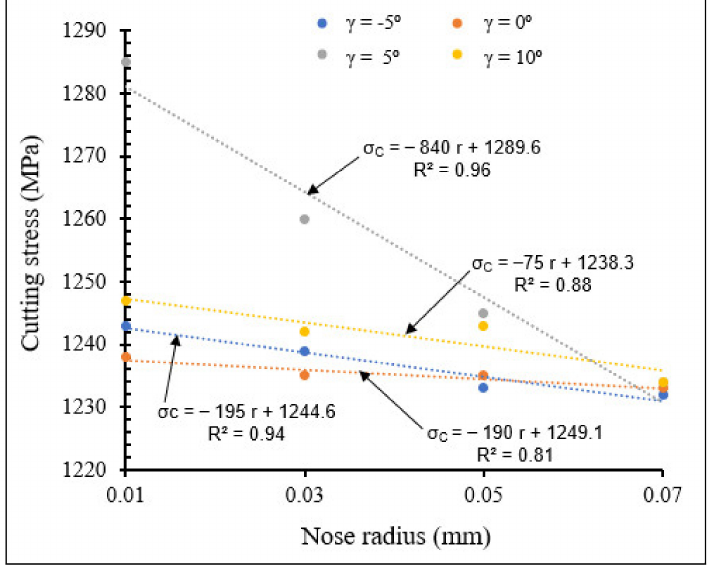
Figure 22. Variation of cutting stress with small tool nose radius for different rake angles at V = 104 m/min, f = 0.1